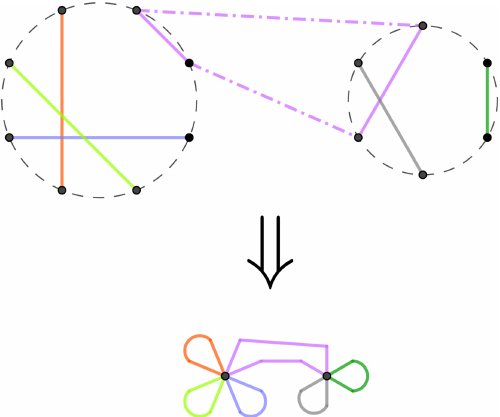
Figure 15 . An example of a pair of chord diagrams translated into the vector model. Edges in both graphs correspond to index sets, with different index sets colored differently. Each trace became a vertex with k/ 2 pairs of index sets coming out, some of which are contracted to each